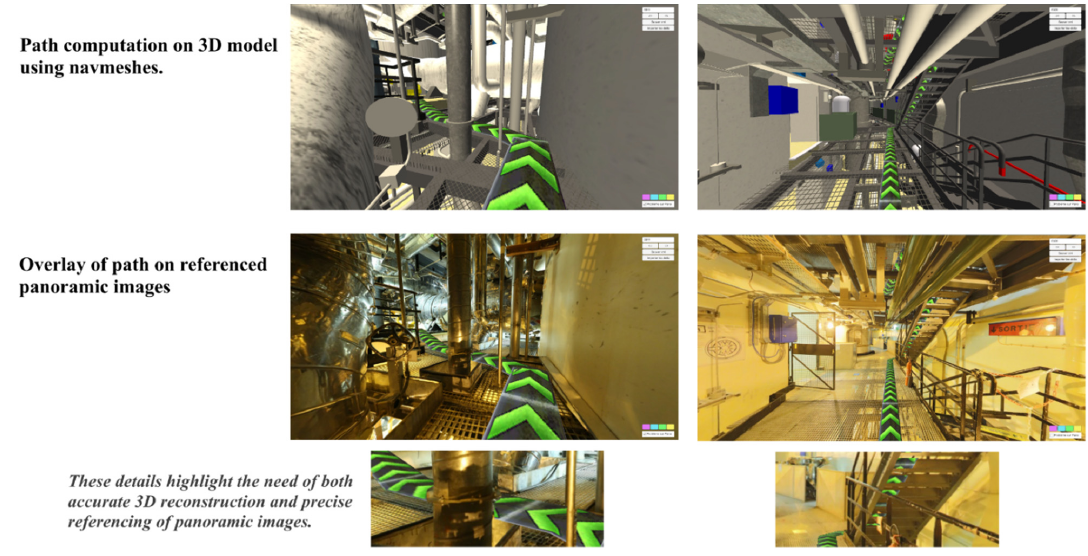
Figure 17. 3D pedestrian path (using navmeshes) overlay on panoramic images.